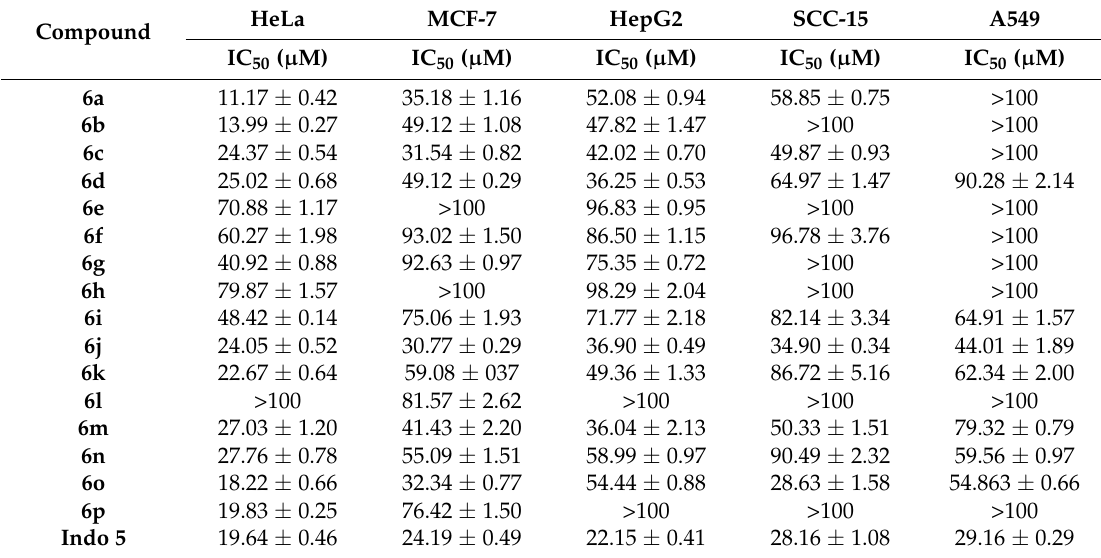
Table 2. The anti-cancer activity of compounds 6a ~ 6p